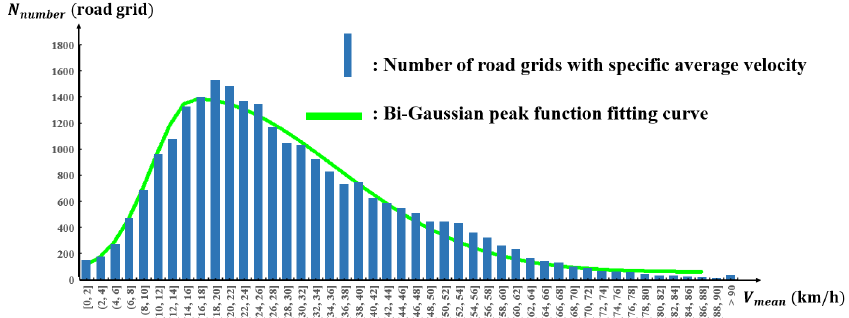
Figure 9. The correlation between the number of road grids with specific average velocity, N number , and the mean velocity of vehicles, V mean